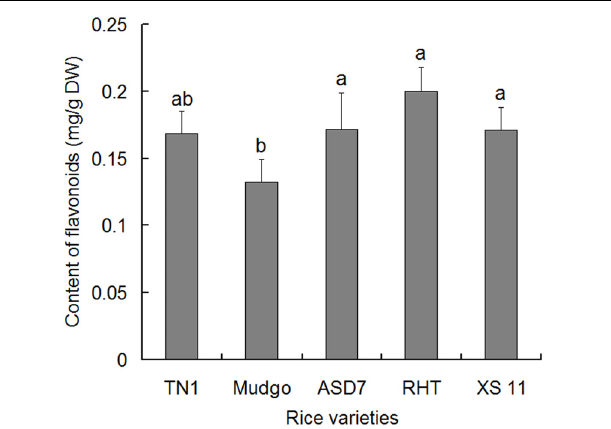
FIGURE 1 | Content of total flavonoids in the leaf sheathes of different rice varieties. Data were presented as means ± SD ( n = 5). Data were analyzed using one-way ANOVA and post-hoc analysis with Tukey’s HSD test, and relative content with the same letter were not significantly different ( P < 0.05). DW, dried